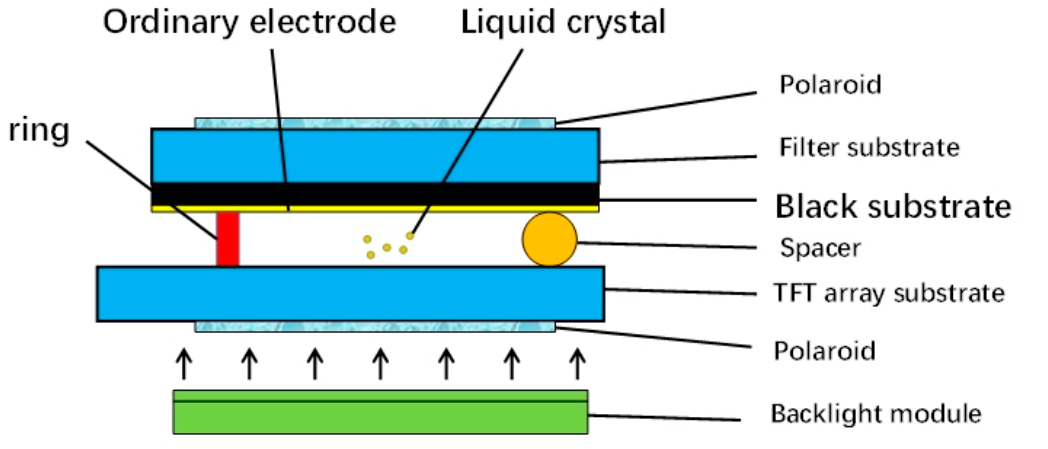
Figure 4. Diagram of TFT structure.